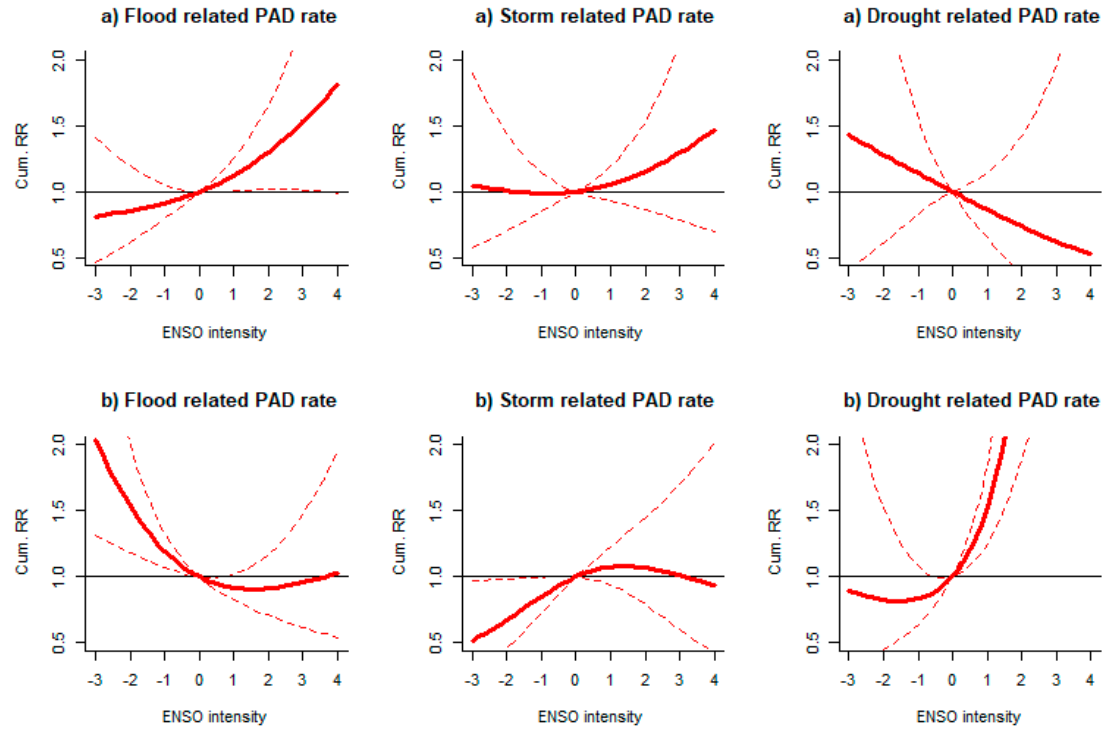
Figure 3. Relationship between global rates of PAD by specific disasters and ENSO intensity in the same year. Cum. RR: Cumulative relative risk. El Niño years defined as ( a ) type 1 events; and ( b ) type 2 events. Events: ONI > 0.5 ◦ C (for EN) or < − 0.5 ◦ C (for LN), otherwise neutral in five consecutive three-months overlapping seasons. ENSO intensity: = 4 for very strong (ONI ≥ 2 ◦ C), = 3 for strong (1.5–1.9 ◦ C), = 2 for moderate (1.0–1.4 ◦ C) and = 1 for weak (0.5–0.9 ◦ C), and similarly for La Niña events based on negative values.